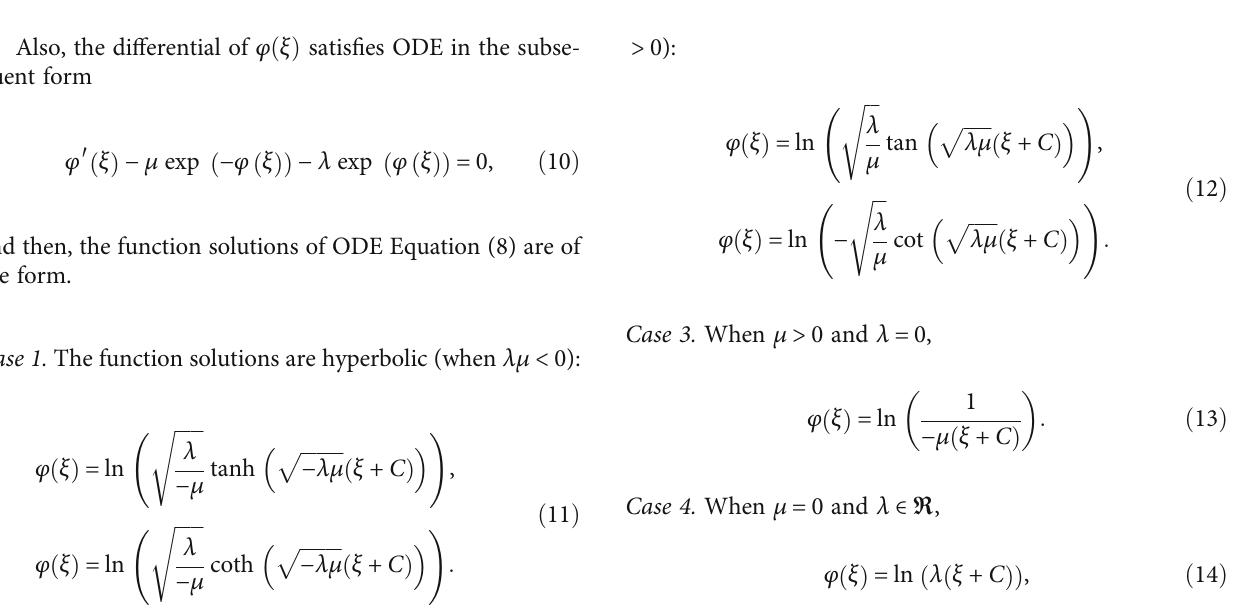
Figure 6: Dynamical behavior of function solution of u